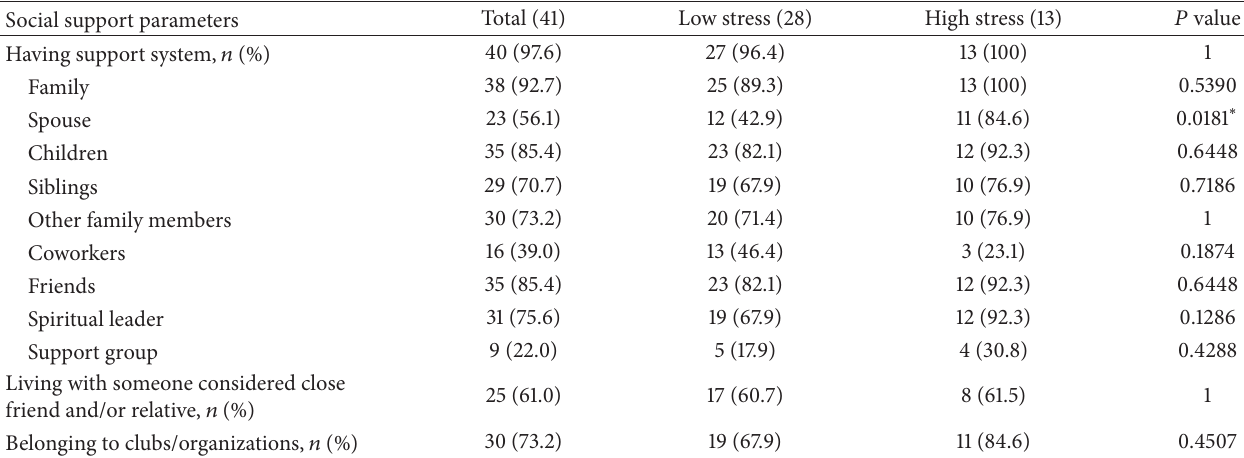
Table 2: Social support characteristics of SLE cases in the Buffalo Lupus Project and Breakfast with a Buddy Biomarkers of Lupus Study ( 𝑁 = 41 ).